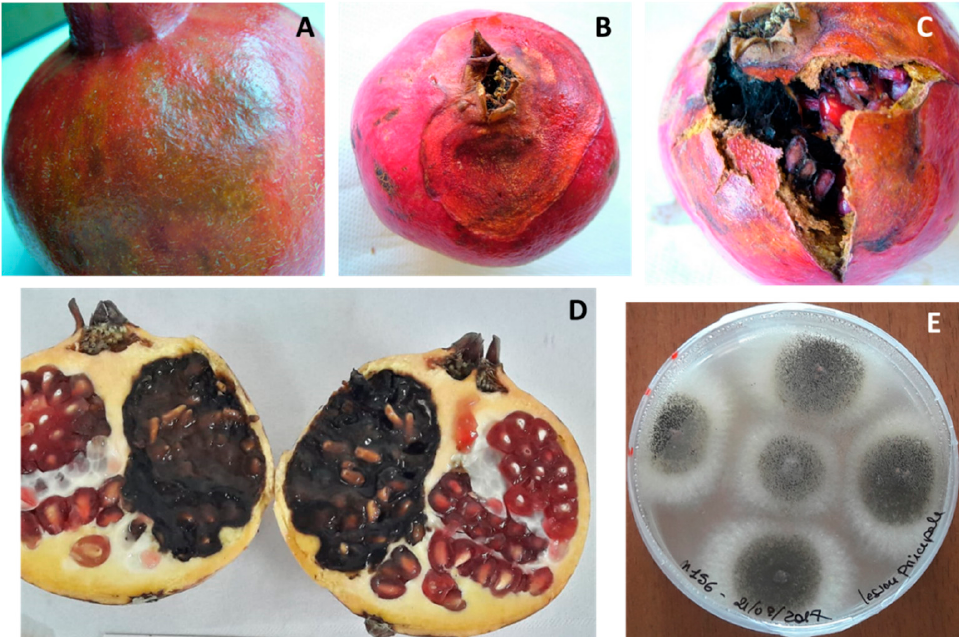
Figure 5. Aspergillus sect. nigri rot. ( A ) Early and ( B ) advanced stages of the disease. ( C ) Rind cracking of diseased fruit. ( D ) View of internal decay; significant is the soft texture of the tissues. ( E ) Front of a PDA plate of Aspergillus spp.